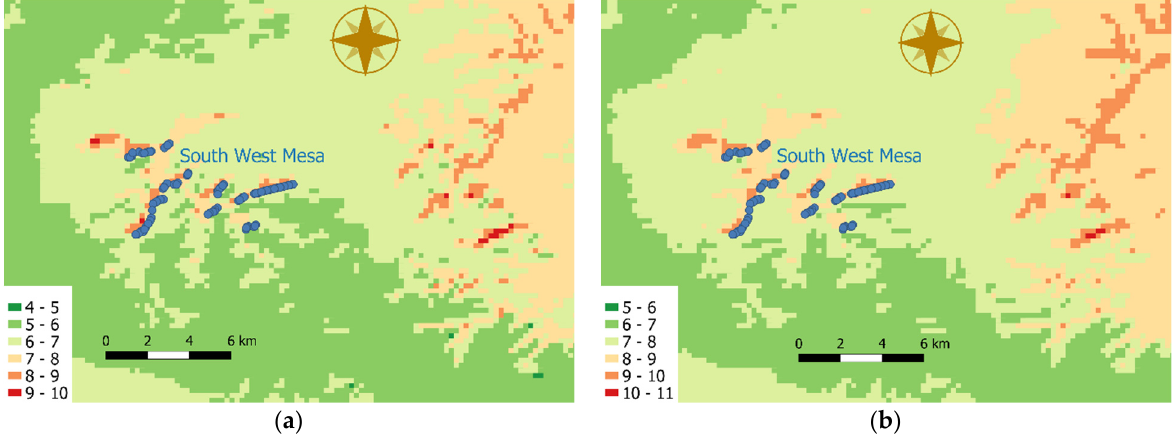
Figure 16. Evaluation of total repowering and size growth for the South West Mesa wind farm overlaid with wind speed vector at ( a ) 50 m height and ( b ) 100 m height.